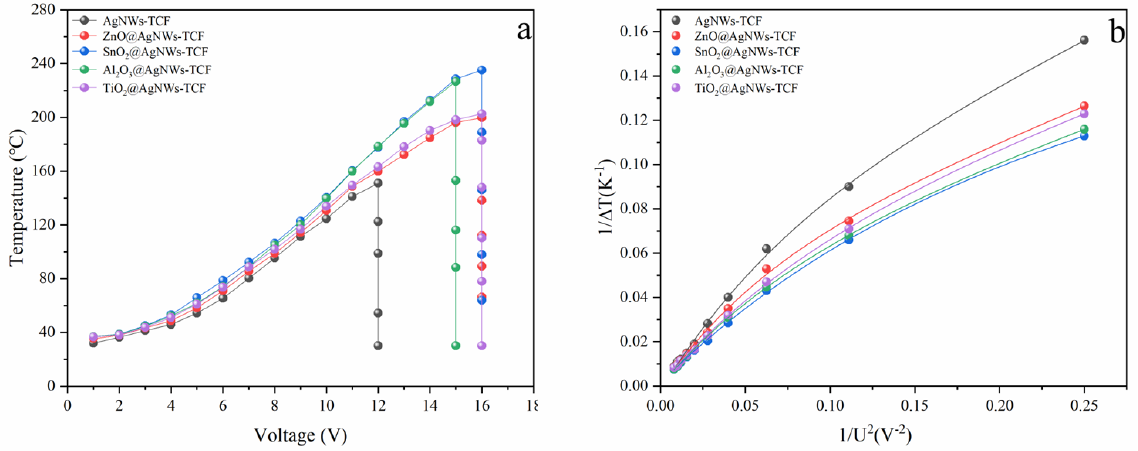
Figure 5. ( a ) Response of temperature with load voltage. ( b ) corresponds to the relationship between 1/ΔT and 1/U 2 .